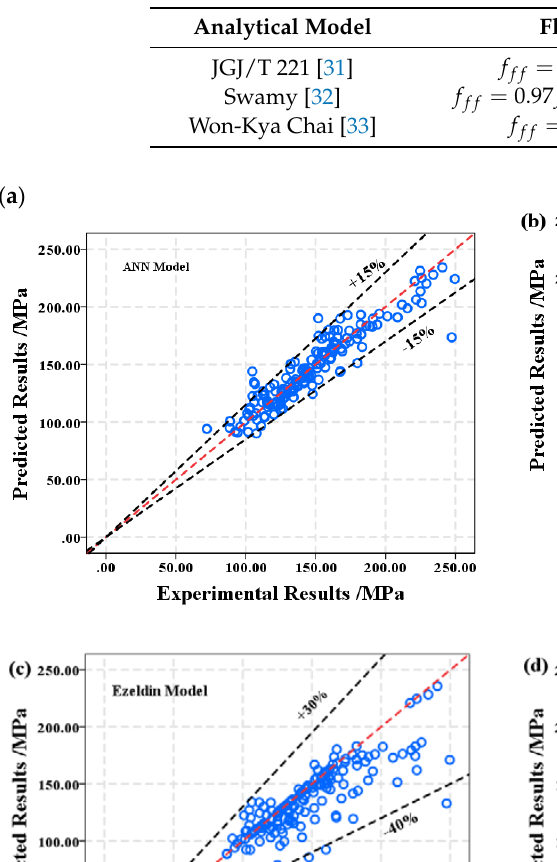
Table 9. Analytical models for predicting the Flexural strength of SFRC.